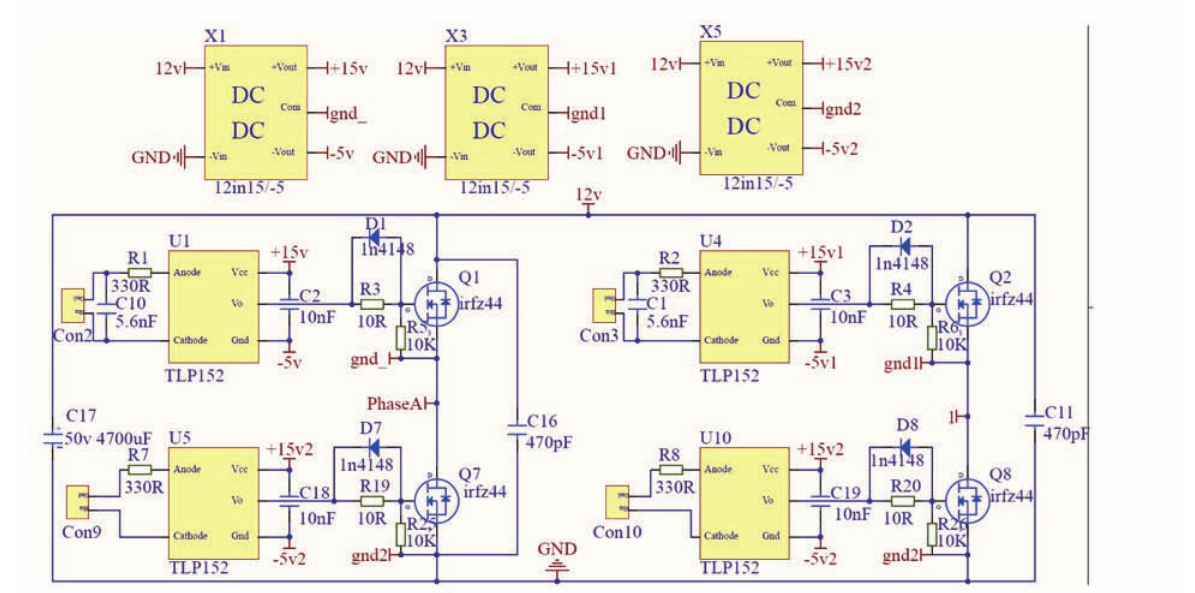
Fig. 12. Circuit diagram of each bridge generated by electronic design automation software.